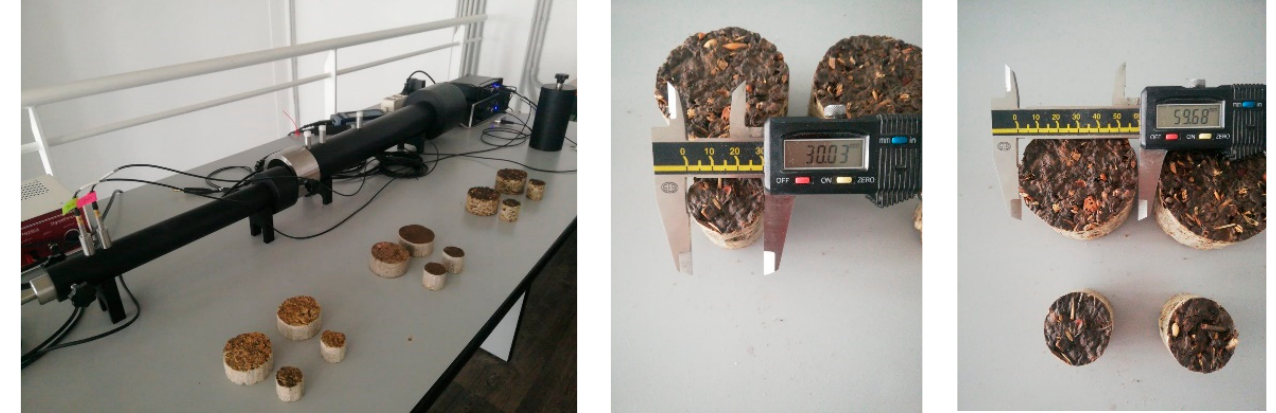
Figure 2. The normal incidence sound absorption coefficient measurement set-up and specimen sizes.